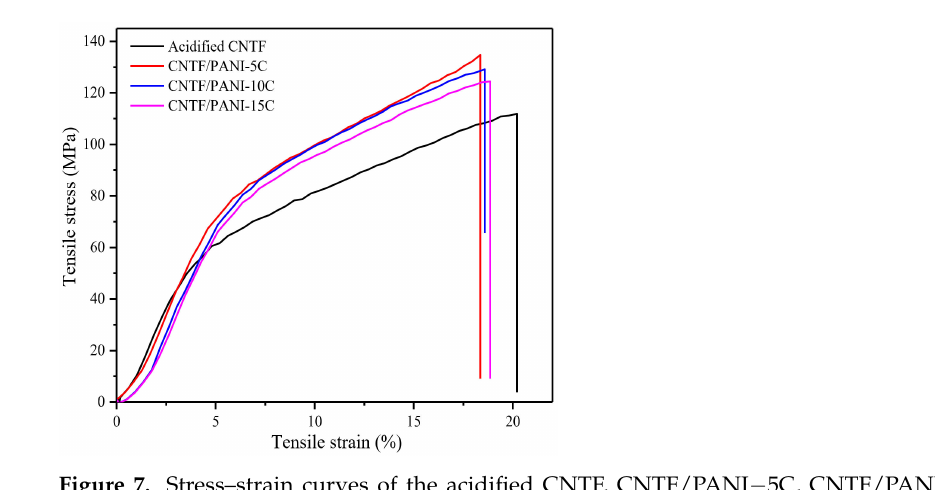
Figure 7. Stress–strain curves of the acidified CNTF, CNTF/PANI − 5C, CNTF/PANI-10C, and CNTF/PANI-15C